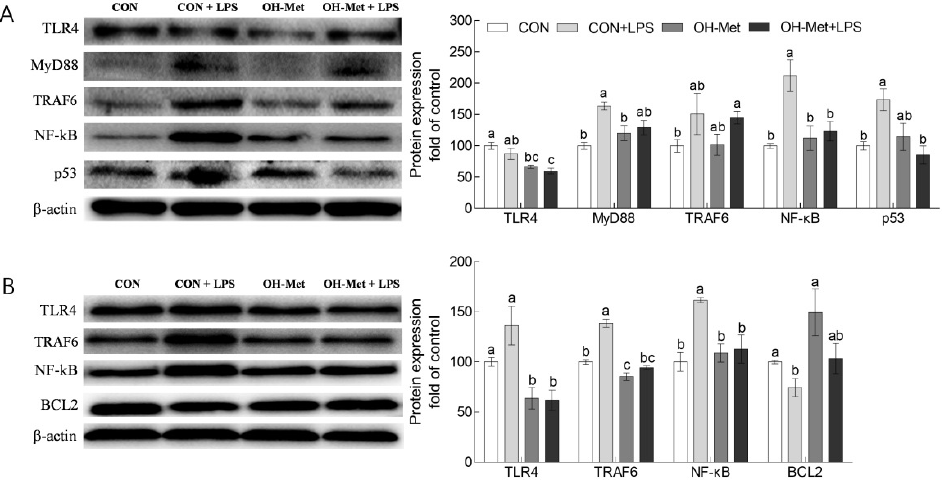
Figure 4. The effects of OH-Met supplementation onTLR4 and NODs signal-related protein produc- tion of the ( A ) liver and ( B ) spleen after 24 h LPS challenge in weaned piglets. The values are the means ± SEs, n = 3–4. The labeled means without a common letter differ, p < 0.05. CON, piglets receiving a control diet and injected with saline; CON+LPS, piglets receiving the control diet and challenged with LPS; OH-Met, piglets receiving a diet that was supplemented OH-Met at 25% above the total SAA present in the CON diet and injected with saline; OH-Met+LPS, piglets receiving a diet that was supplemented OH-Met at 25% above the total SAA present in the CON diet and challenged with LPS.